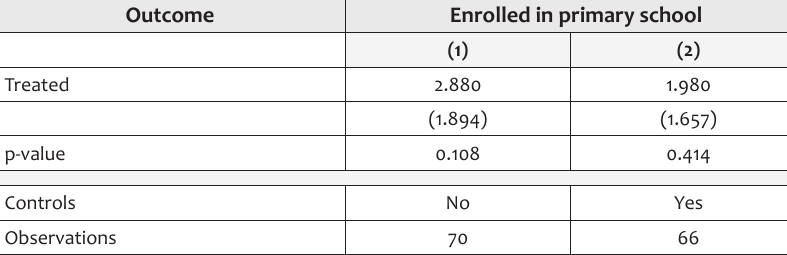
Table 6: School enrolment outcomes